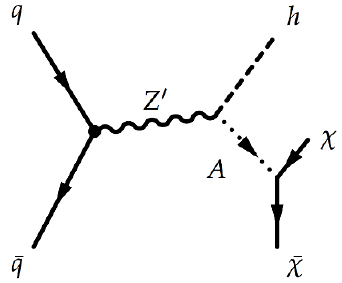
Figure 1 . Leading order Feynman diagram of the Z 0 -2HDM \simpli(cid:12)ed model". A pseudoscalar boson A decaying into invisible dark matter is produced from the decay of an on-shell Z 0 resonance. This gives rise to a Higgs boson and missing transverse